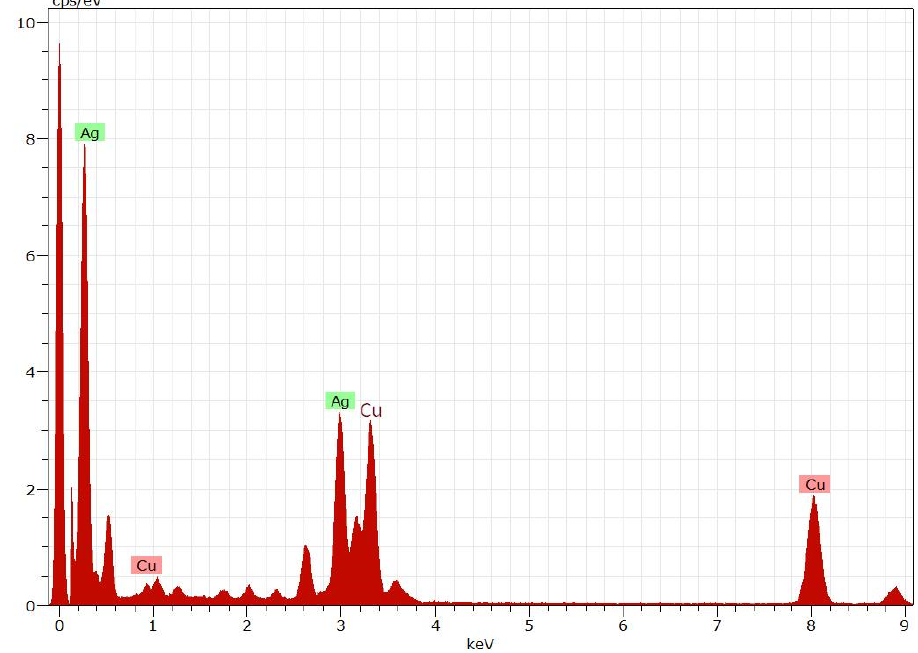
Figure 4. Energy-dispersive X-ray (EDX) analysis showing a strong peak of silver from synthesized Asf-AgNPs.